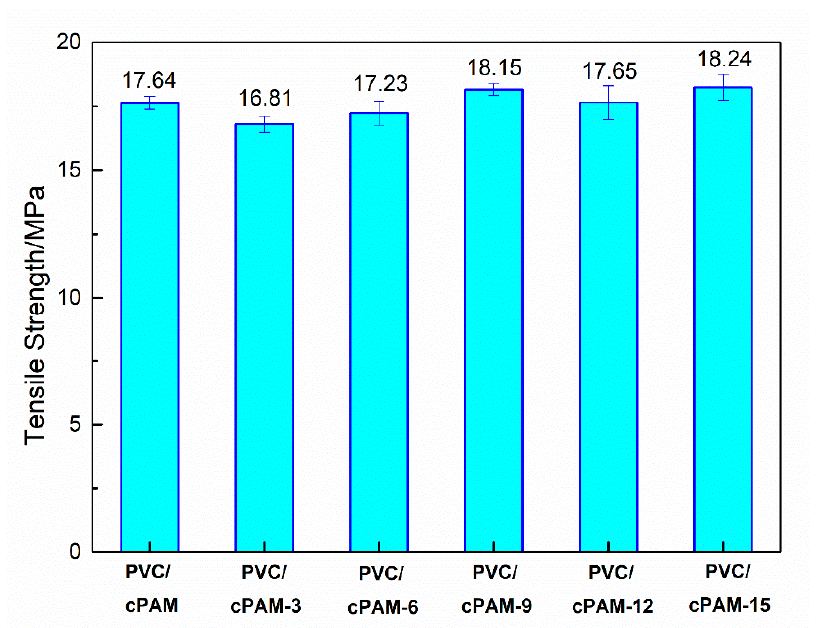
Figure 16. Tensile strength of the PVC modified by cPAM.